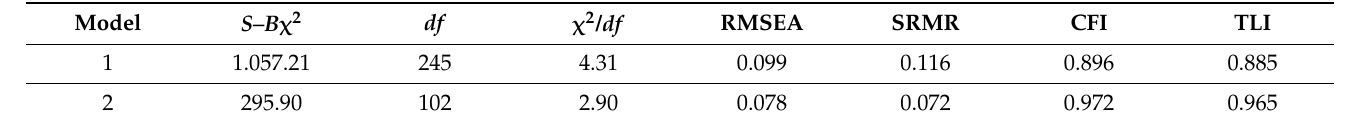
Table 3. Model fit indices of the proposed